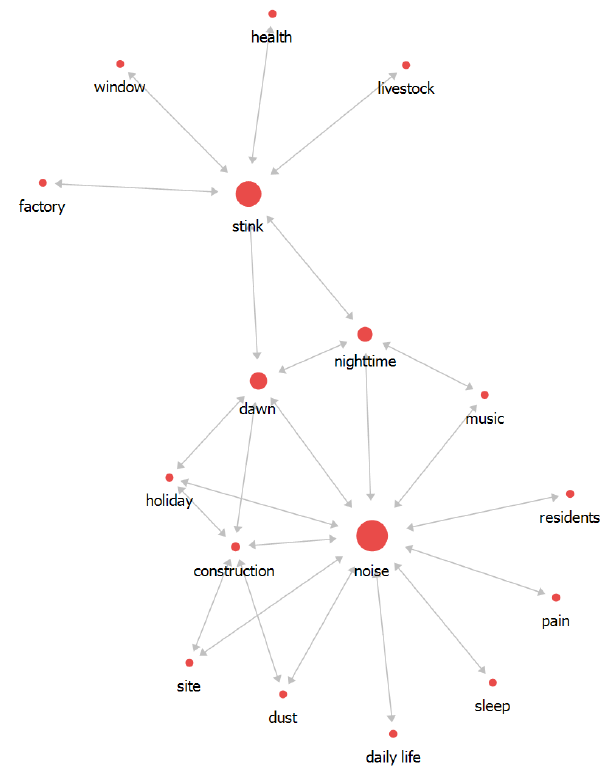
F igure 4. The relationship between words in 2014. Figure 4. The relationship between words in